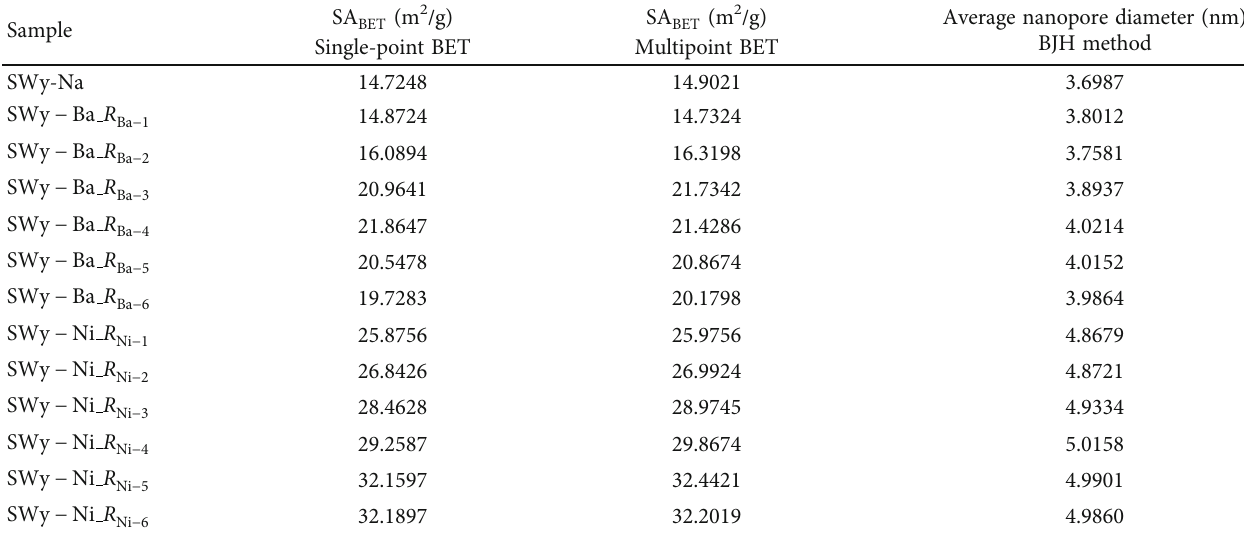
Table 9: SA (single and multipoint BET) and BJH method average pore BET